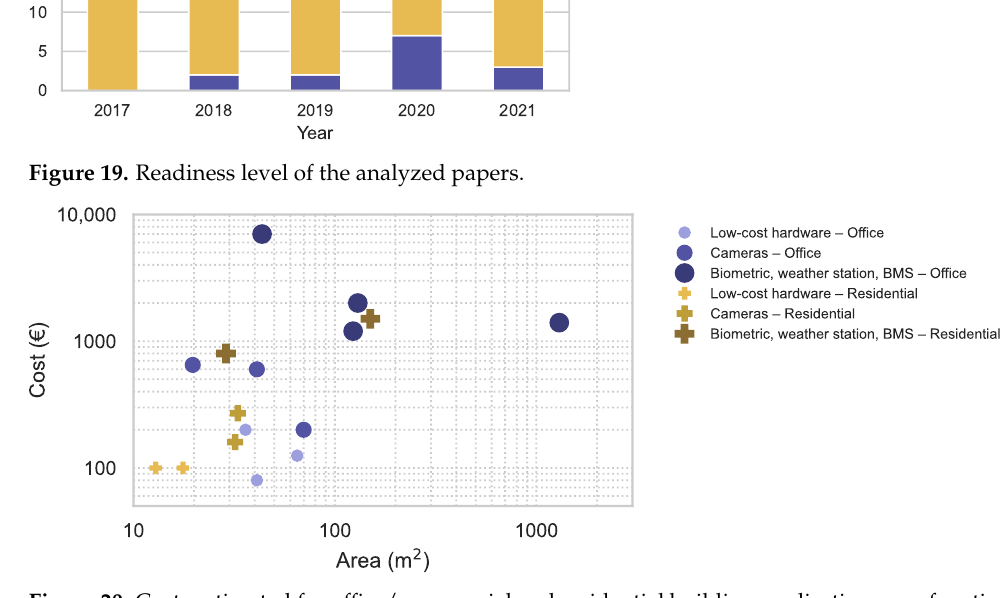
Figure 20. Costs estimated for office/commercial and residential building applications as a function of conditioned area (bi-logarithmic